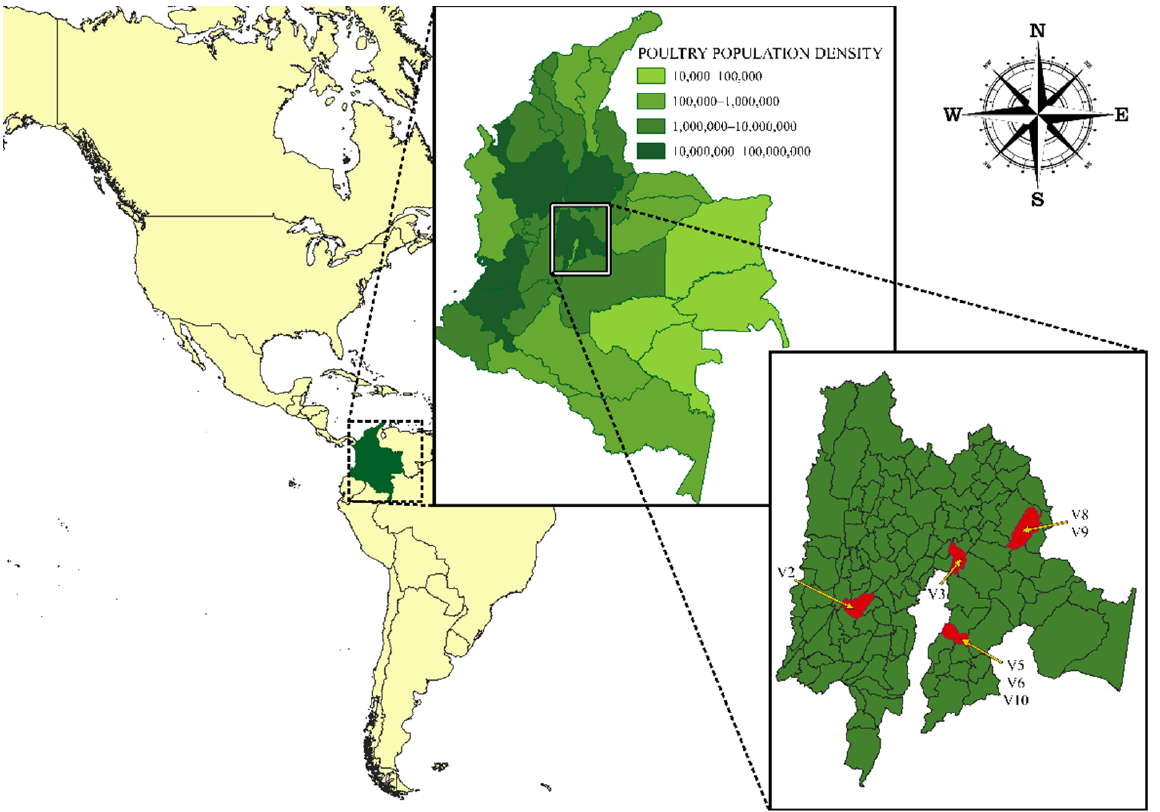
Figure 1. Geographical location of the farms from which the Infectious Bronchitis Virus (IBV) isolates included in the study were obtained. The lower right image shows the exact location of the farms and the seven IBV isolates (V2, V3, V5, V6, V8, V9, and V10).